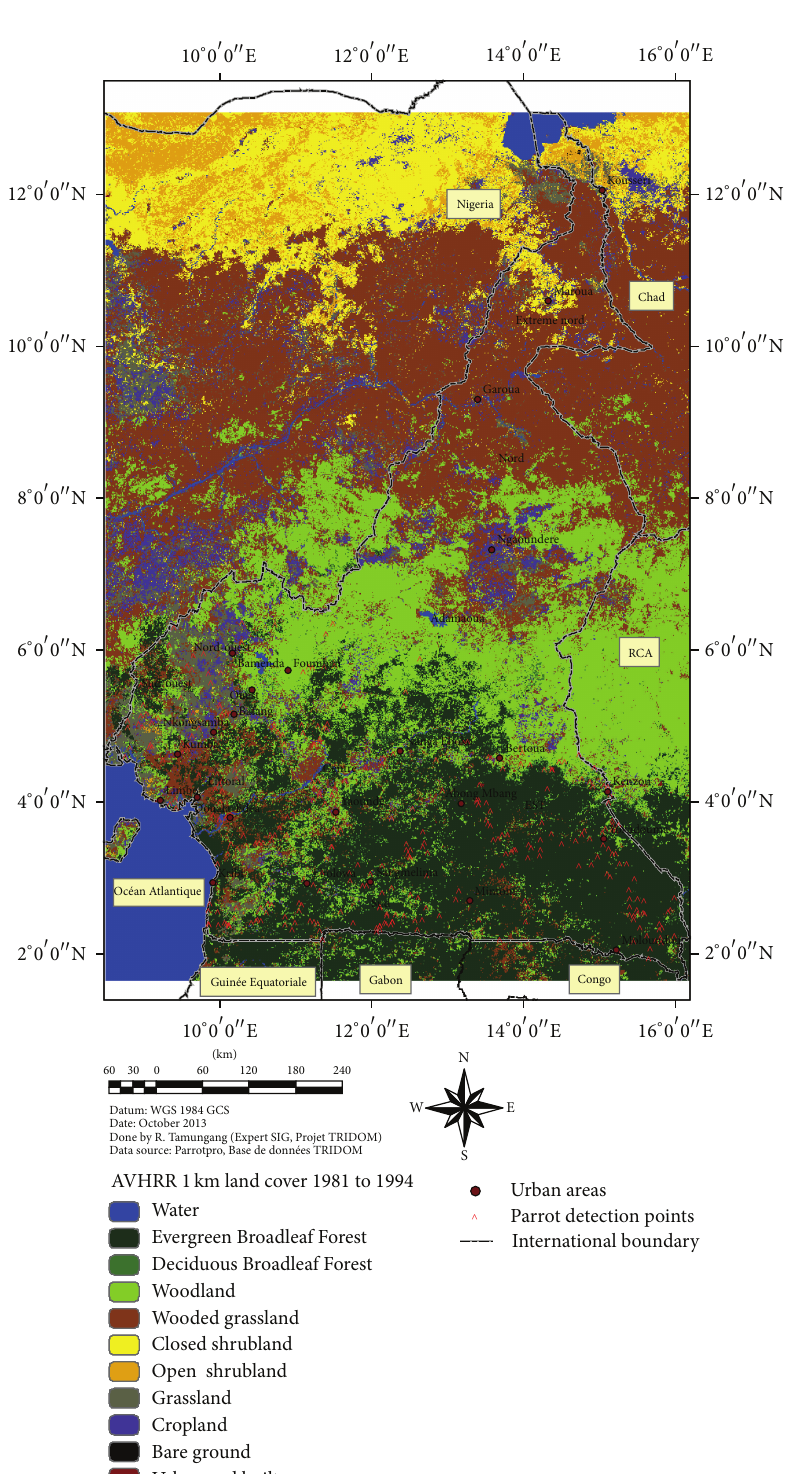
Figure 5: Current distribution of Grey Parrots in vegetation cover in Cameroon in relation to parrot detection